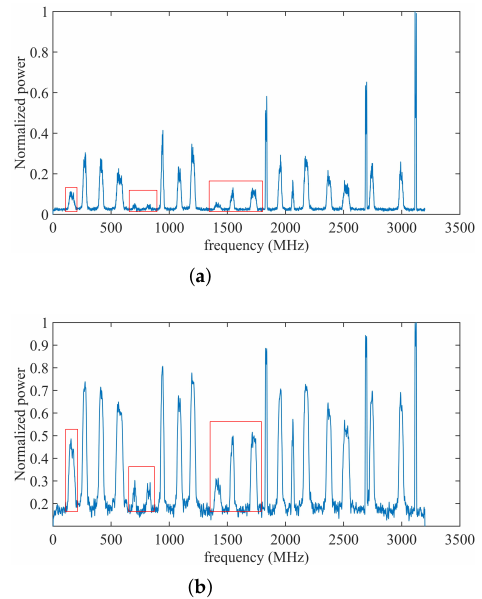
Figure 3. Signal enhancement using logarithmic transformation. ( a ) before enhancement; ( b ) af- ter